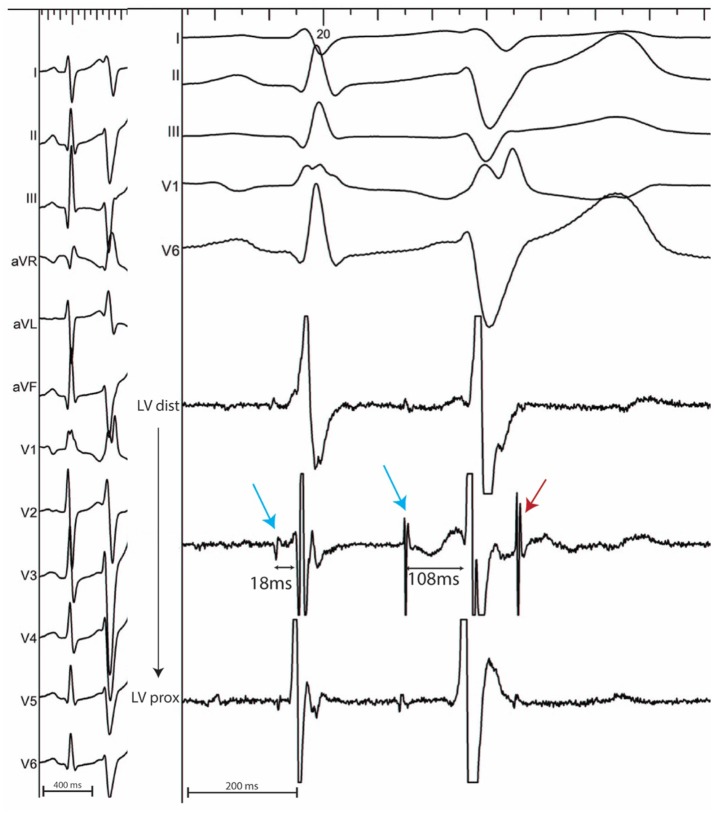
12 lead ECG with associated endocardial electrograms of a PVC arising from the posterior Purkinje network. Purkinje fascicular potentials precede QRS onset by 18 ms during sinus rhythm. During the PVC, Purkinje potentials precede QRS onset by 108 ms (blue arrows). Notice the presence of a concealed Purkinje potential (red arrow).